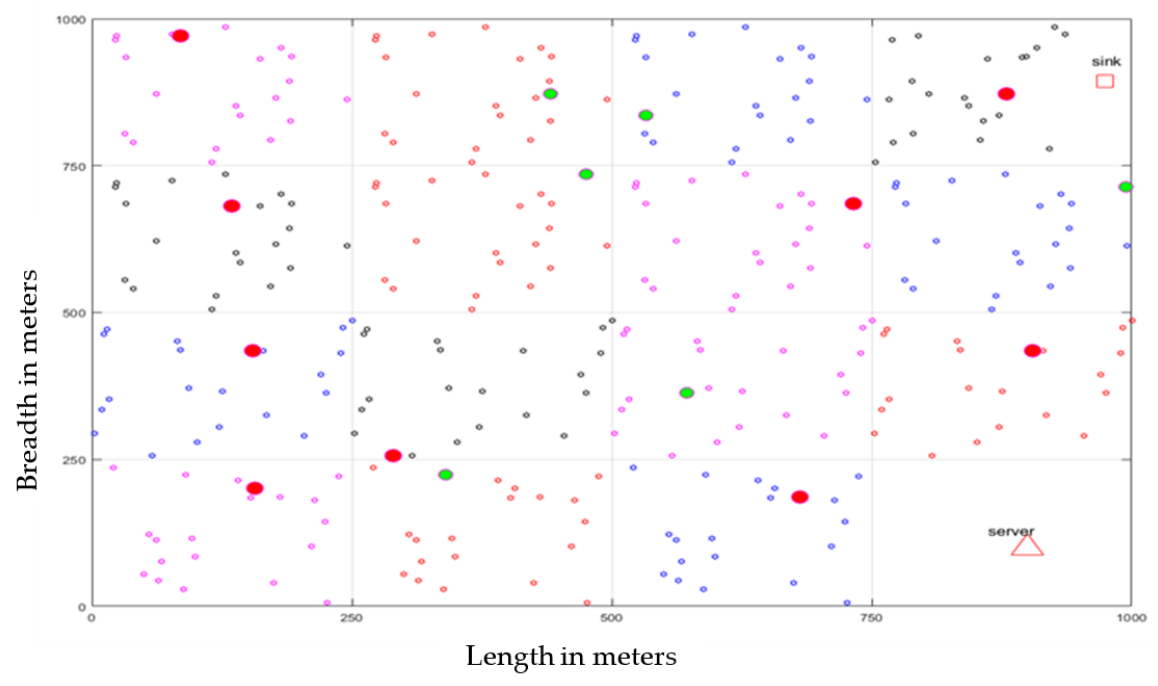
Figure 8. Selection of grid organizer as a relay node.